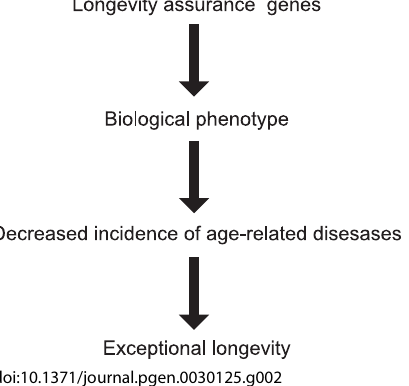
Figure 2. The Stages Needed in Order to Support the Association of a Genotype with Longevity While Figure 1 demonstrates how to obtain genotypes in genes that are important for the assurance of longevity, the verification of such genotypes requires additional analyses. First, one should seek evidence of a relevant biological phenotype. These may include in vitro and in vivo functional assays that demonstrate appropriate alterations in genes and the determination of plasma or tissue levels of substances that reflect an intermediate phenotype. Second, one should ideally develop lines of evidence demonstrating that a given genotype is protective against common diseases of aging, i.e., that the genotypes also modulate health span. These various steps should help to establish genetic factors contributing to exceptional longevity. As such, they should serve as major clues to the pathogenesis of common diseases of aging, thus providing rational strategies of prevention (see